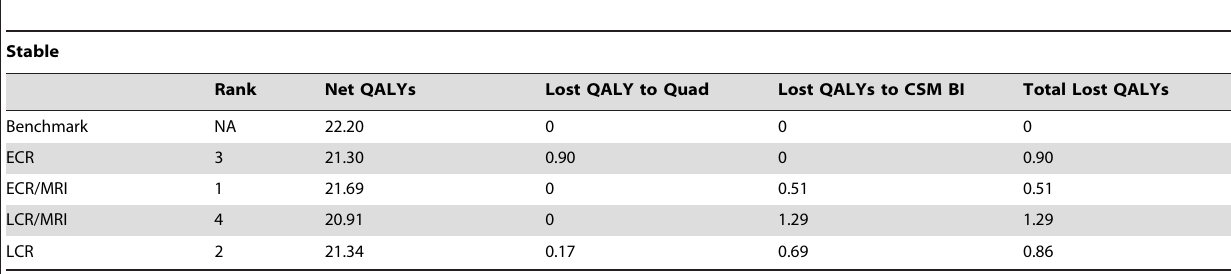
Table 5. QALYs Resulting from Quadriplegia and CS Management Complications with a 5.0% Probability of Cervical Spine Instability in the Stable category of